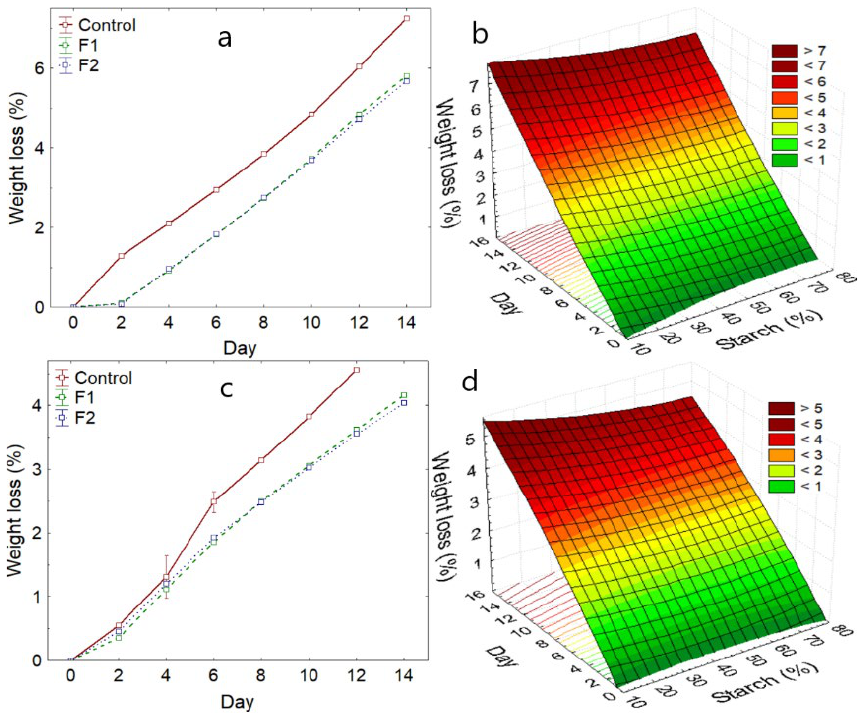
Figure 6. Variation of weight loss, ( a ) Hass variety, ( b ) with respect to the addition of starch—Hass